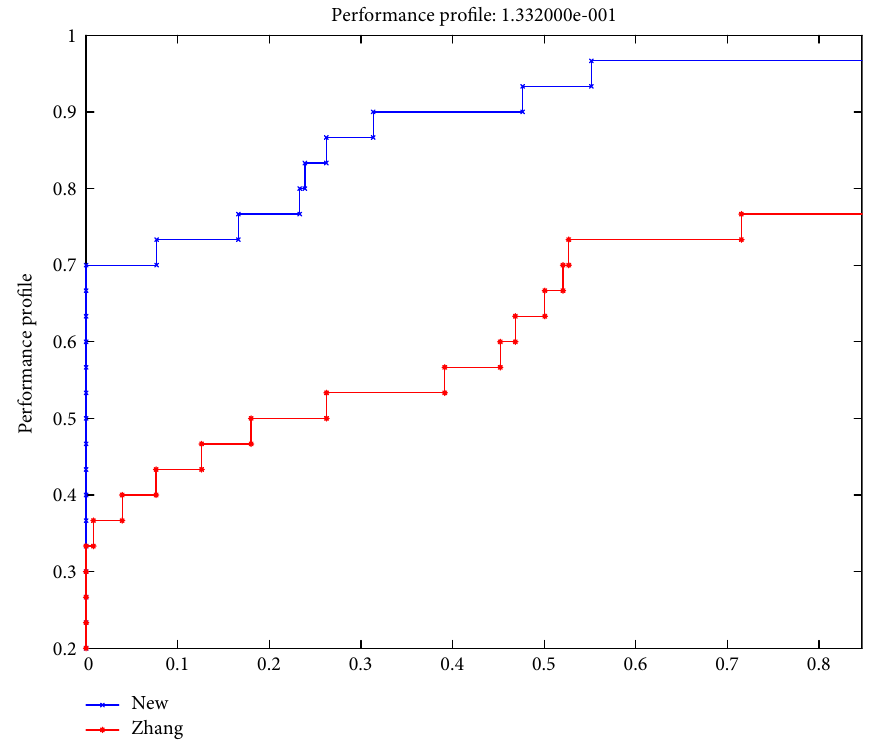
Figure 1: Performance profiles based on function evaluation.